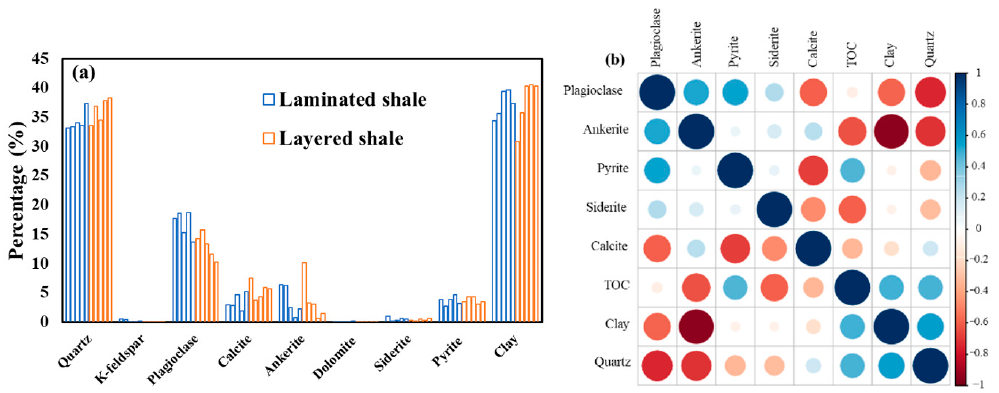
Figure 2. ( a ) Mineralogy analysis from 5 wells in the first member; and ( b ) mineral correlation